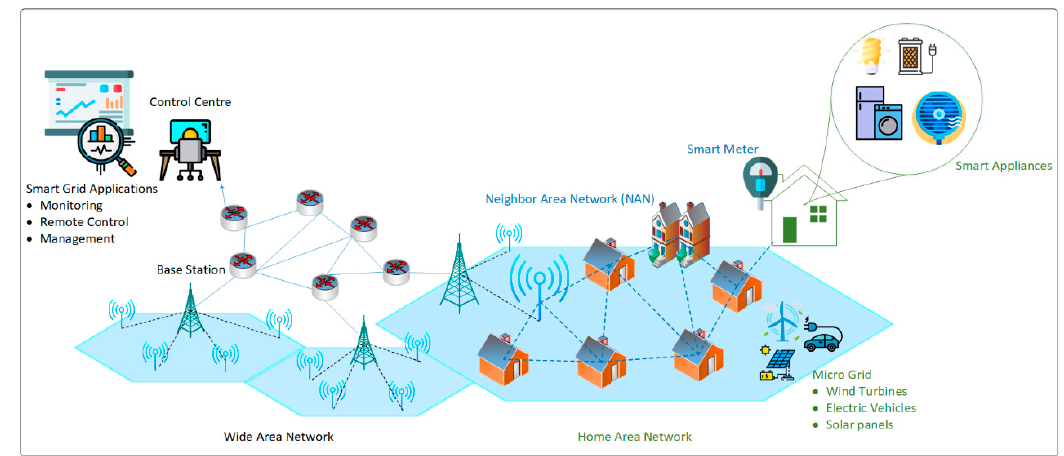
Figure 17. Proposed framework for smart sustainable cities applications.